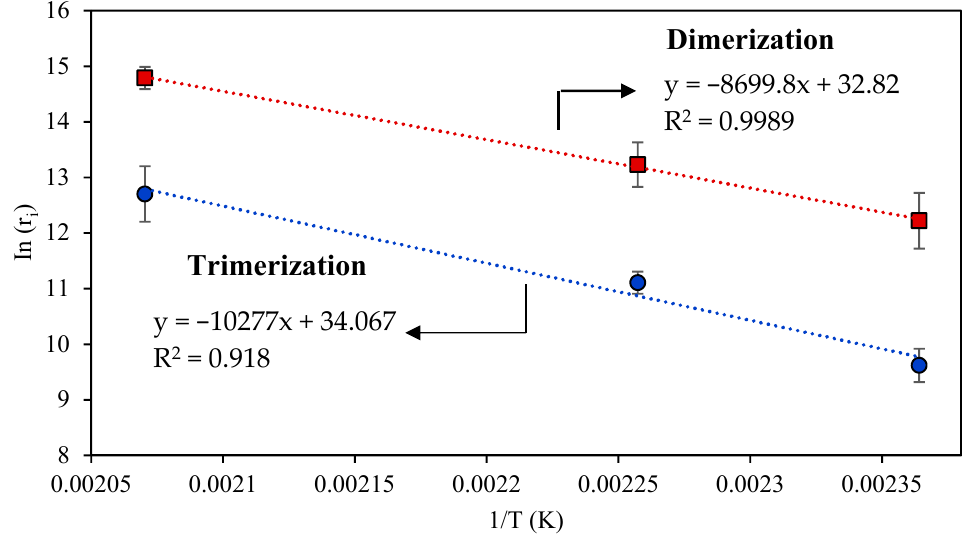
Figure 2. The Arrhenius plot to calculate the activation energy for the microwave assisted oligomerization reaction of 1 - decene over the HY zeolite catalyst .